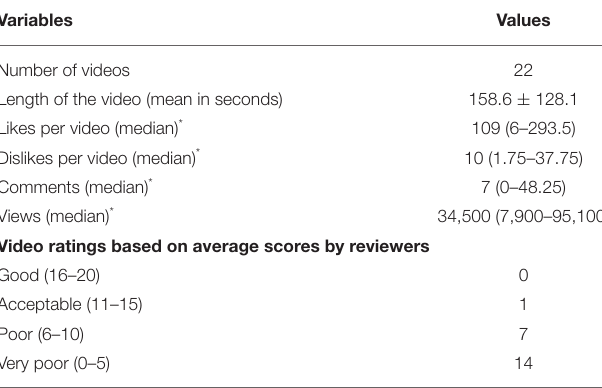
TABLE 2 | YouTube characteristics of the analyzed videos.